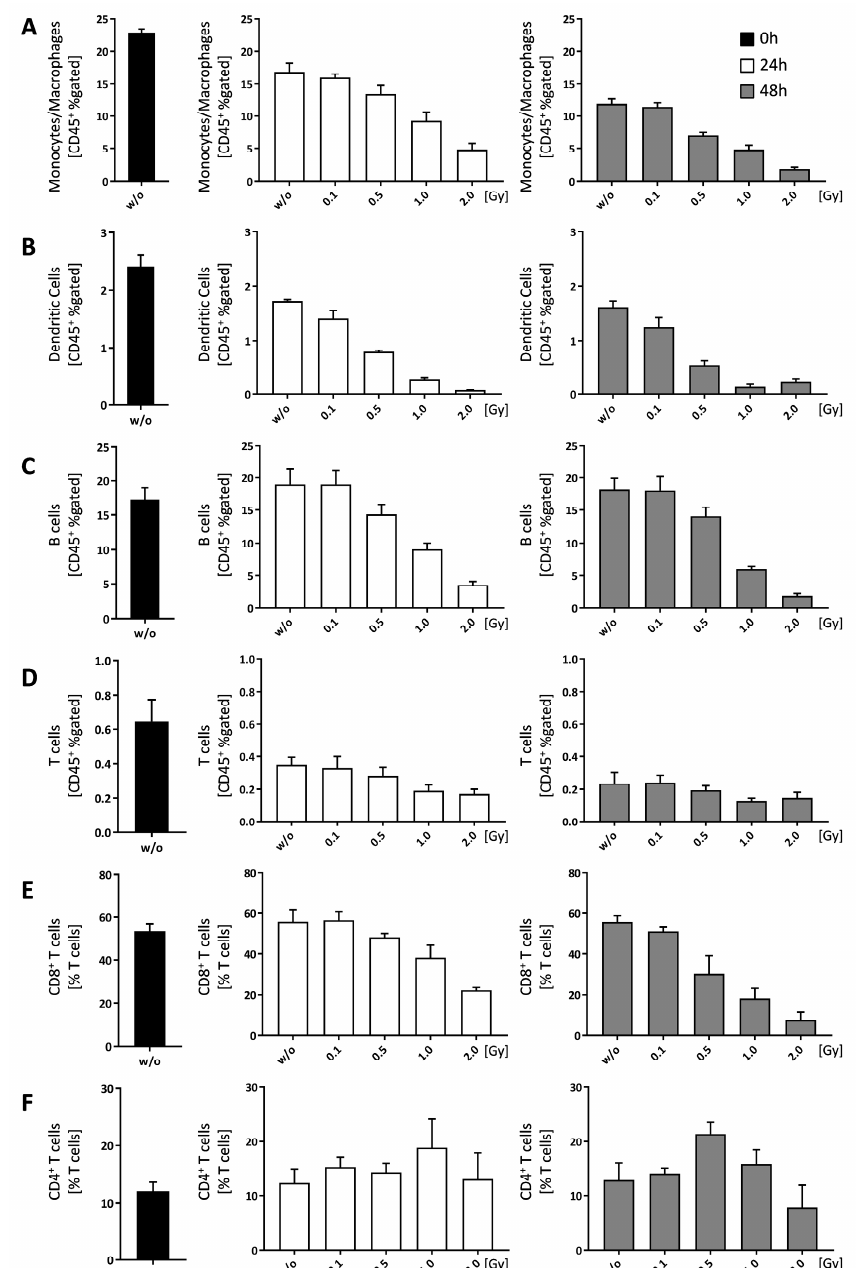
Figure 6. Ionizing radiation alters immune cell composition in bone-marrow of C57Bl/6 mice. Bone-marrow cells were isolated from the long bones of male C57Bl/6 mice. For analyses 1 × 10 6 cells were seeded in duplicates and analyzed at different time points (0, 24 and 48 h). In order to distinguish live from dead cells a zombie dye (BioLegend, San Diego, CA, USA) was used and the displayed results are all related to living cells. CD45 + cells have then been gated into immune cell subpopulations according to specific surface markers: ( A ) Monocytes/Macrophages; ( B ) Dendritic cells; ( C ) B cells; ( D ) T cells; T cells have been further classified into CD8 + ( E ) and CD4 + ( F ) T cells, respectively. Depicted is joint data from one experiment with three 6 weeks old male mice whose bone-marrow has been analyzed independently and in duplicates. Data is presented as mean ± SEM.